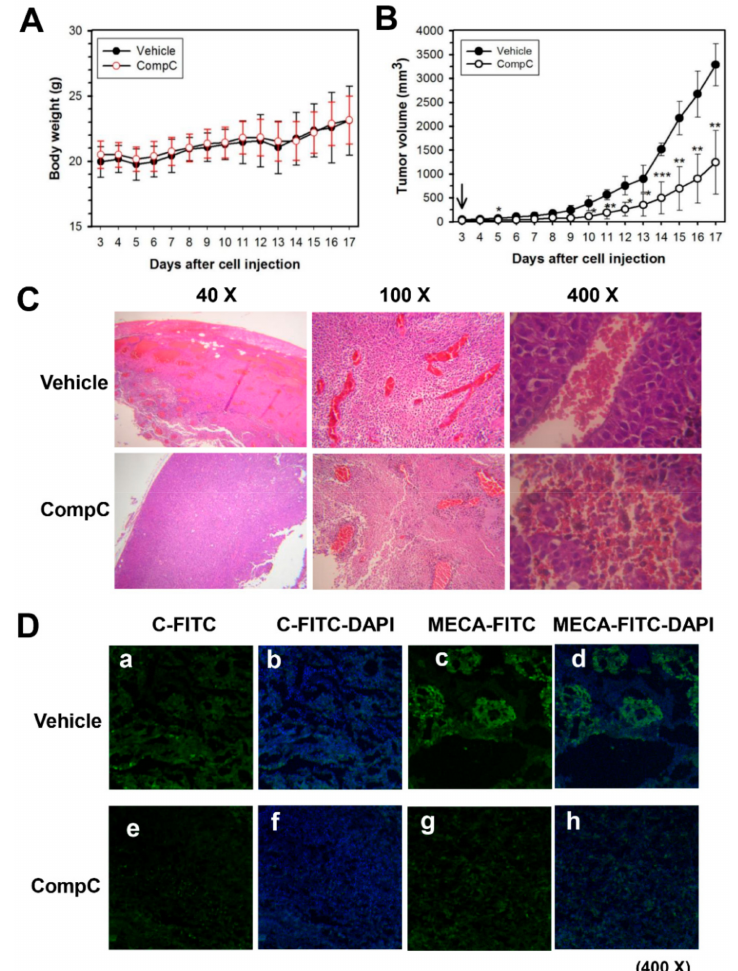
Figure 5. CompC inhibited B16-F1 tumor growth and angiogenesis in C57BL / 6 mice. ( A , B ) Three days after B16-F1 tumor cell injection, vehicle or CompC (2.5 mg / kg / day) was intraperitoneally injected into the tumor-bearing mice. Body weight and tumor volume were measured and plotted in ( A , B ) respectively. Significant di ff erence between vehicle and CompC injection groups at each day is marked with an asterisk ( p < 0.05, Mann-Whitney U test). ( C , D ) On 14 days after daily injection of vehicle or CompC, tumors were excised and either embedded in para ffi n for H&E staining ( C ) or frozen in Tissue-Tek O.C.T. tissue matrix compound for immunofluorescence staining ( D ). Tumors stained with H&E (40–100 × ) or immunostained with ( c , d , g , h ) or without anti-MECA32 antibodies (negative control: a , b , e , and f ) in the presence of FITC-conjugated secondary antibodies and 4 (cid:48) ,6-diamidino-2-phenylindole (DAPI) stain were photographed (400 ×